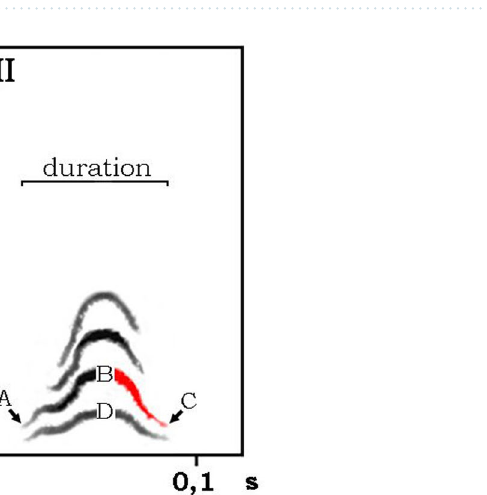
Figure 2. The level of correct classifications of Call-1 to individuals ( n = 31 individuals, 310 calls). Individuals were ordered according to growing level of correct classifications.